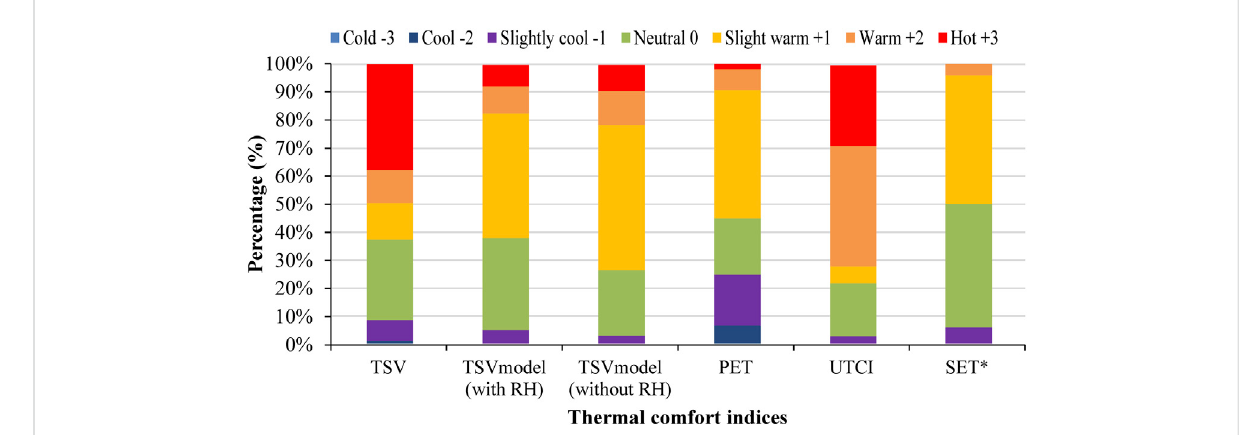
FIGURE 5 Percentage of thermal indices ’ class